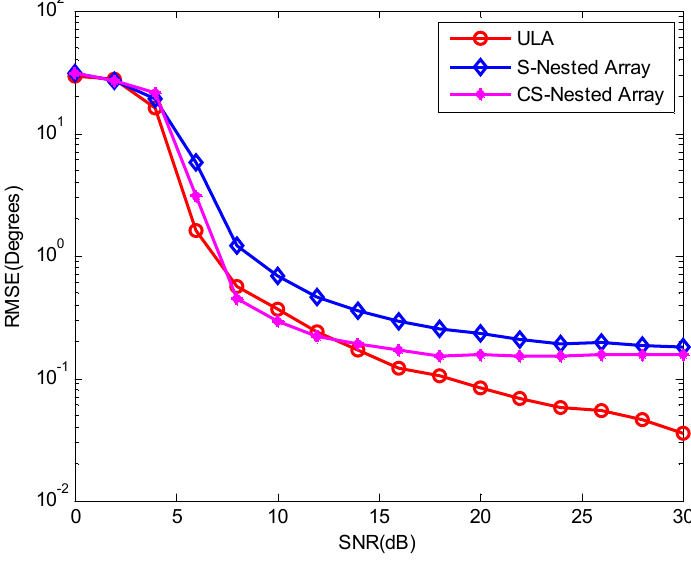
Figure 4. RMSE as a function of SNR for three methods.